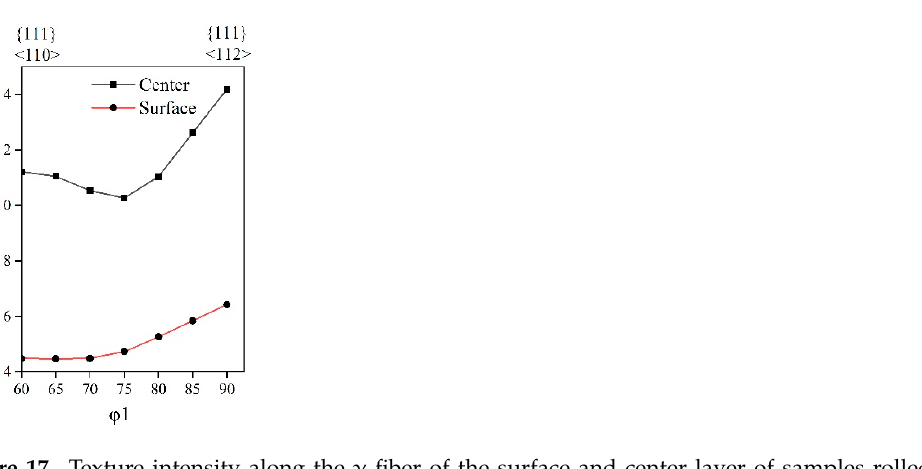
Figure 16. EBSD IPF orientation maps of IF steel after annealing; surface map of ( a ) 800 °C—88% and ( b ) 800 °C—78%; center map of ( c ) 800 °C—88% and ( d ) 800 °C—78%.